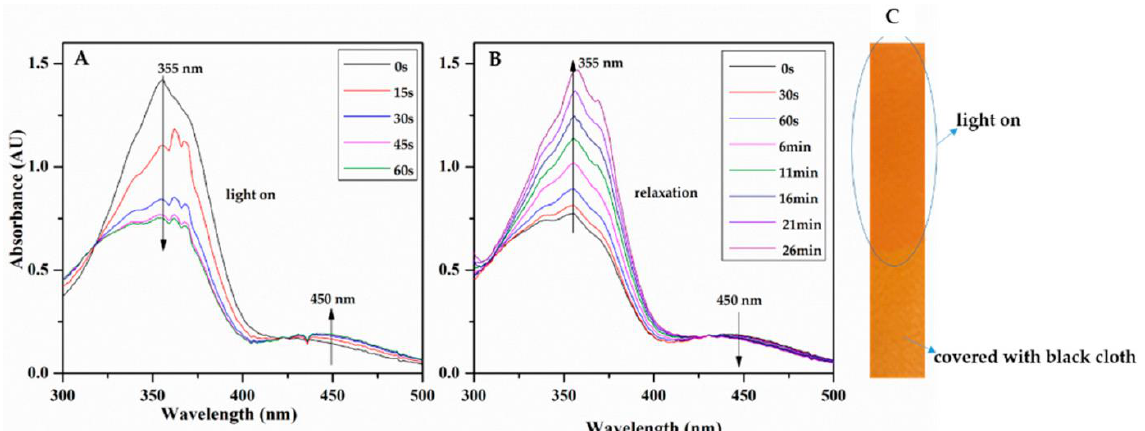
Figure 15. The light-responsive behavior of the MMAZO in ethanol ( A , B ) and the PMMAZO-graft CNCs and polyurethane composite film ( C ). Reuse permitted by the Creative Common CC BY license from Liu, X.; Li, M.; Zheng, X.; Retulainen, E.; Fu, S. Dual Light- and PH-Responsive Composite of Polyazo-Derivative Grafted Cellulose Nanocrystals. Materials 2018 , 11 , 1725, doi:10.3390/ma11091725.